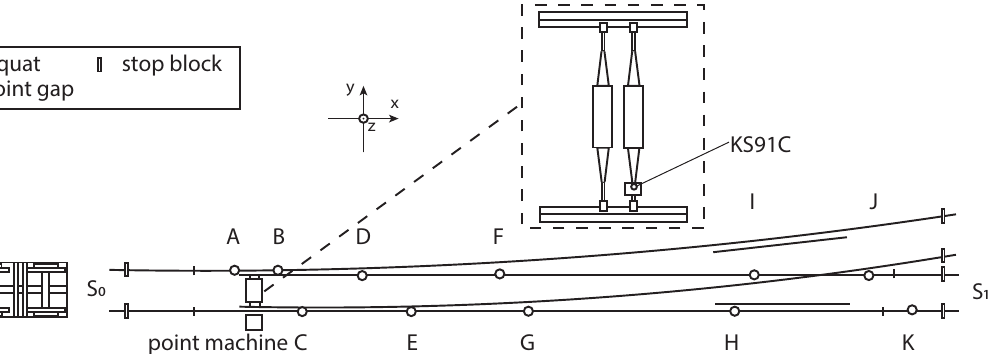
Figure 2. Test bed schematic diagram and accelerometer placement. The squats are labelled from A to K. S 0 and S 1 are stop blocks in the through direction.